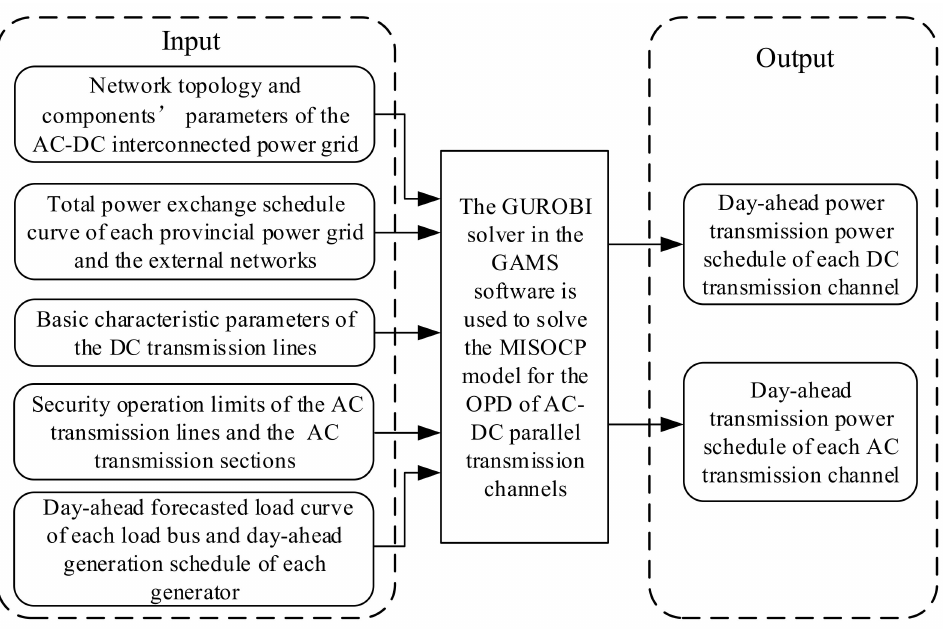
Figure 1. Detailed information about inputs / outputs of the proposed MISOCP algorithm for the OPD of AC-DC parallel transmission